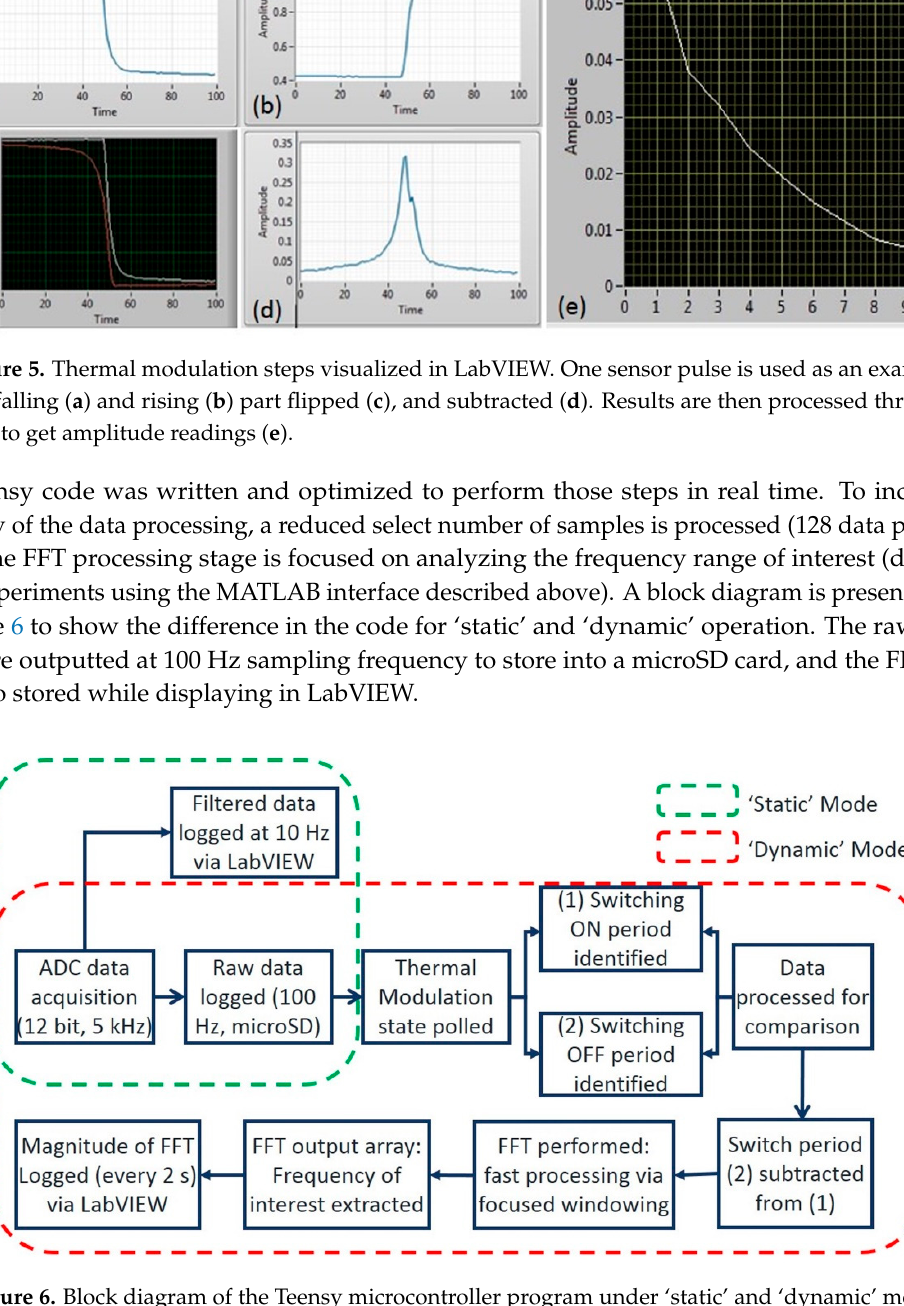
Figure 6. Block diagram of the Teensy microcontroller program under ‘static’ and ‘dynamic’ mode.